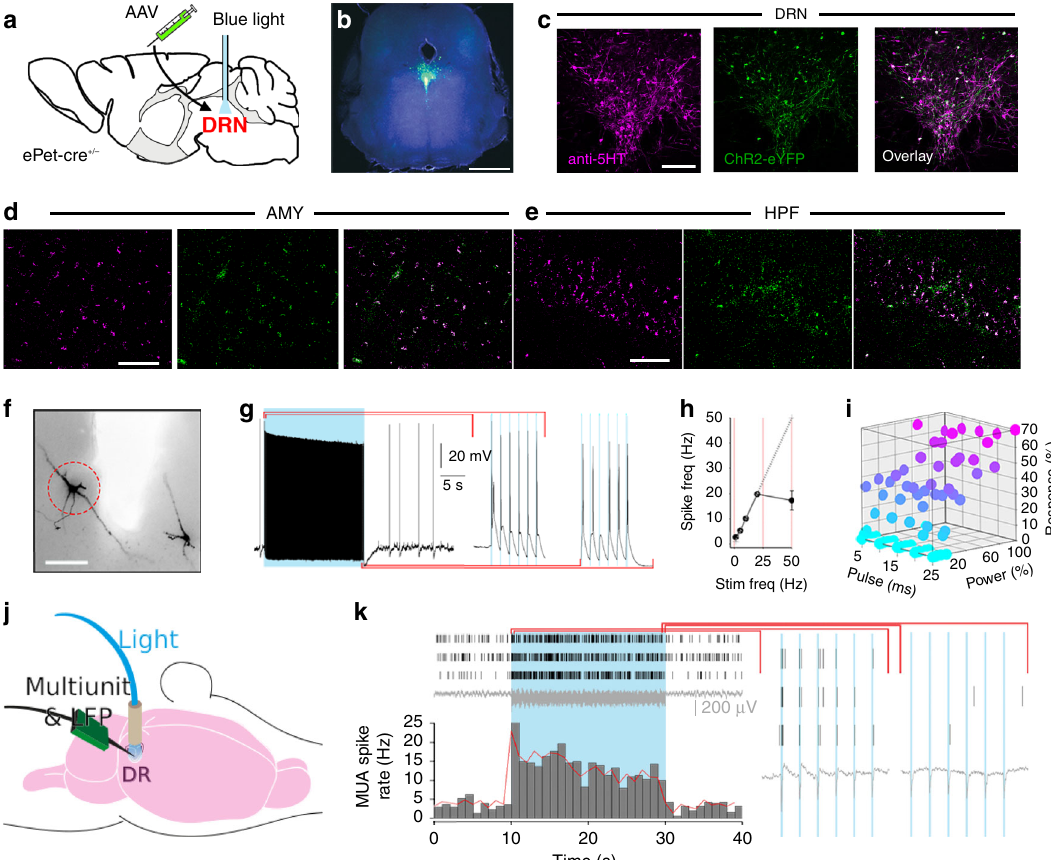
Fig. 1 Optogenetic targeting of DRN 5-HT neurons. a Infusion of AAV harbouring cre-dependent ChR2-eYFP into the DRN of ePet-cre + / − mice, followed by implantation of a MRI-friendly optic fi bre used to deliver blue light. b Whole midbrain slice with Ch2R in green. DAPI (blue) identify all cell nuclei. Scale bar indicates 2.5 mm. c – e Co-immuno fl uorescence with anti-5-HT (purple) and ChR2-eYFP (green) in the ( c ) DRN, ( d ) amygdala (AMY) and ( e ) hippocampus (HPF). Scale bars indicate 500, 100 and 50 µ m, respectively. f Biocytin- fi lled neurons of the DRN used for in vitro whole-cell patch electrophysiology. Red dashed circle indicates recorded neuron. Scale bar indicates 200 µ m. g Response of neuron circled in ( f ) to all but one pulse of a blue light train. h Frequency response curve from midbrain slices. Linearity stable to 20 Hz. i Strength of response expressed in maximum number of spikes per pulse during 20 Hz photostimulation, as a function of pulse width and laser power. j Schematic of the experimental set-up for paired MUA and LFP recordings in the DRN during photostimulation. k Raster plots of MUA activity in three neighbouring channels (top), LFP (middle) and mean spike histogram (bottom), revealing activation of the DRN 5-HT network during a blue light train (20 Hz, 5 ms pulse width). Expanded to the right are the MUA and LFP for the fi rst and last 6 pulses in the